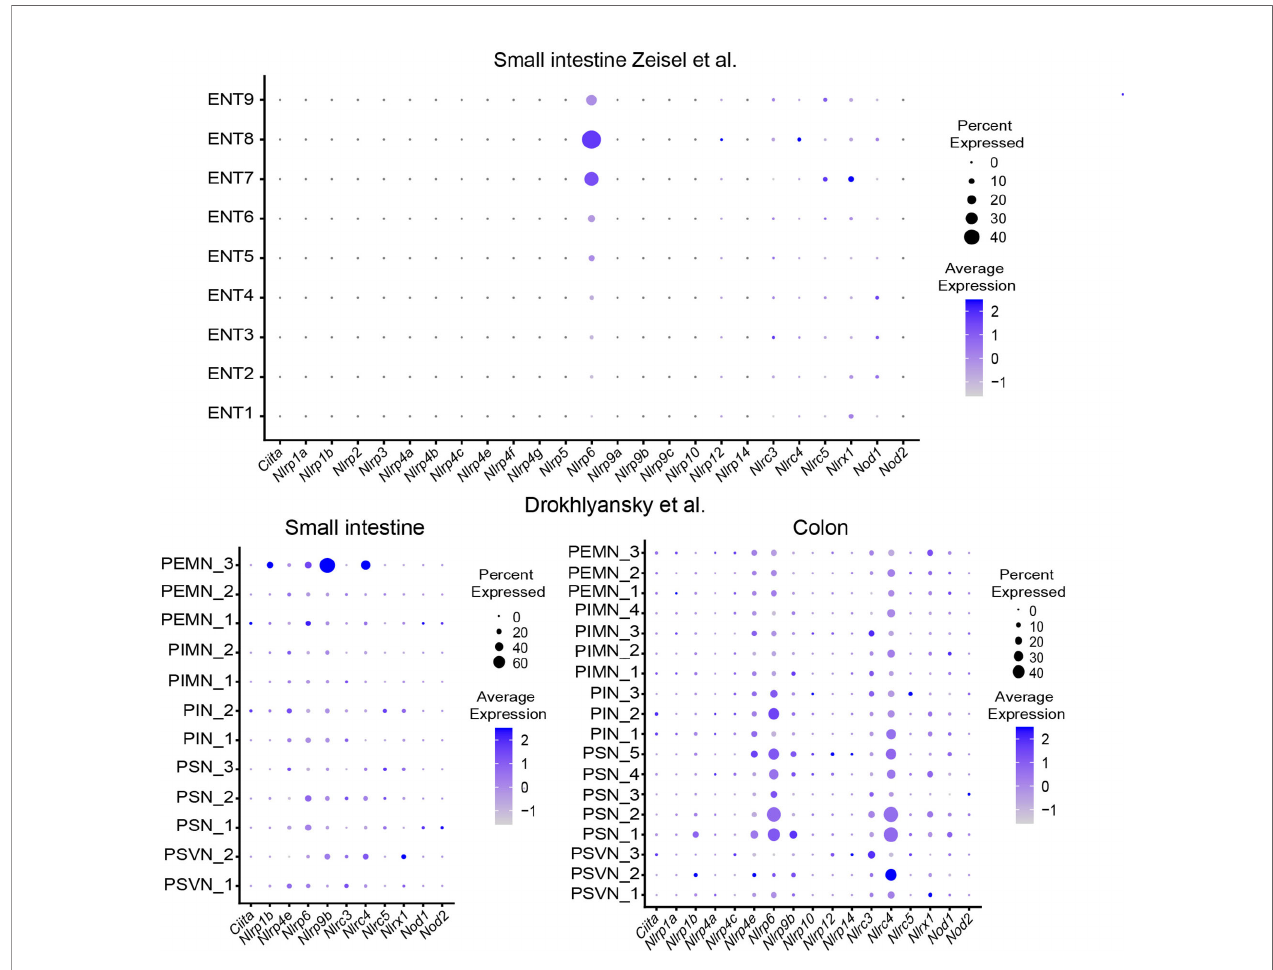
FIGURE 3 | Expression of NOD-like receptors in different ENS subsets. Dotplots showing the percentage of expressing cells as well as average expression within the indicated identi fi ed neuronal clusters for selected murine NOD-like receptor genes. Data was downloaded from http://mousebrain.org/ (12) or from https://singlecell.broadinstitute.org/ (14). Genes not present in the plot showing the Drokhlyansky data have been fi ltered. All dataset were normalized and transformed before the plots were created using the Seurat package